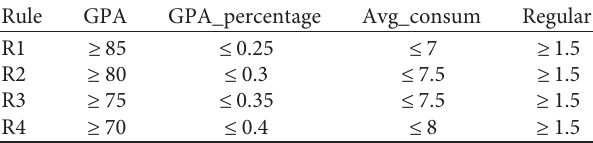
Table 14: Rules for choosing financially difficult students.